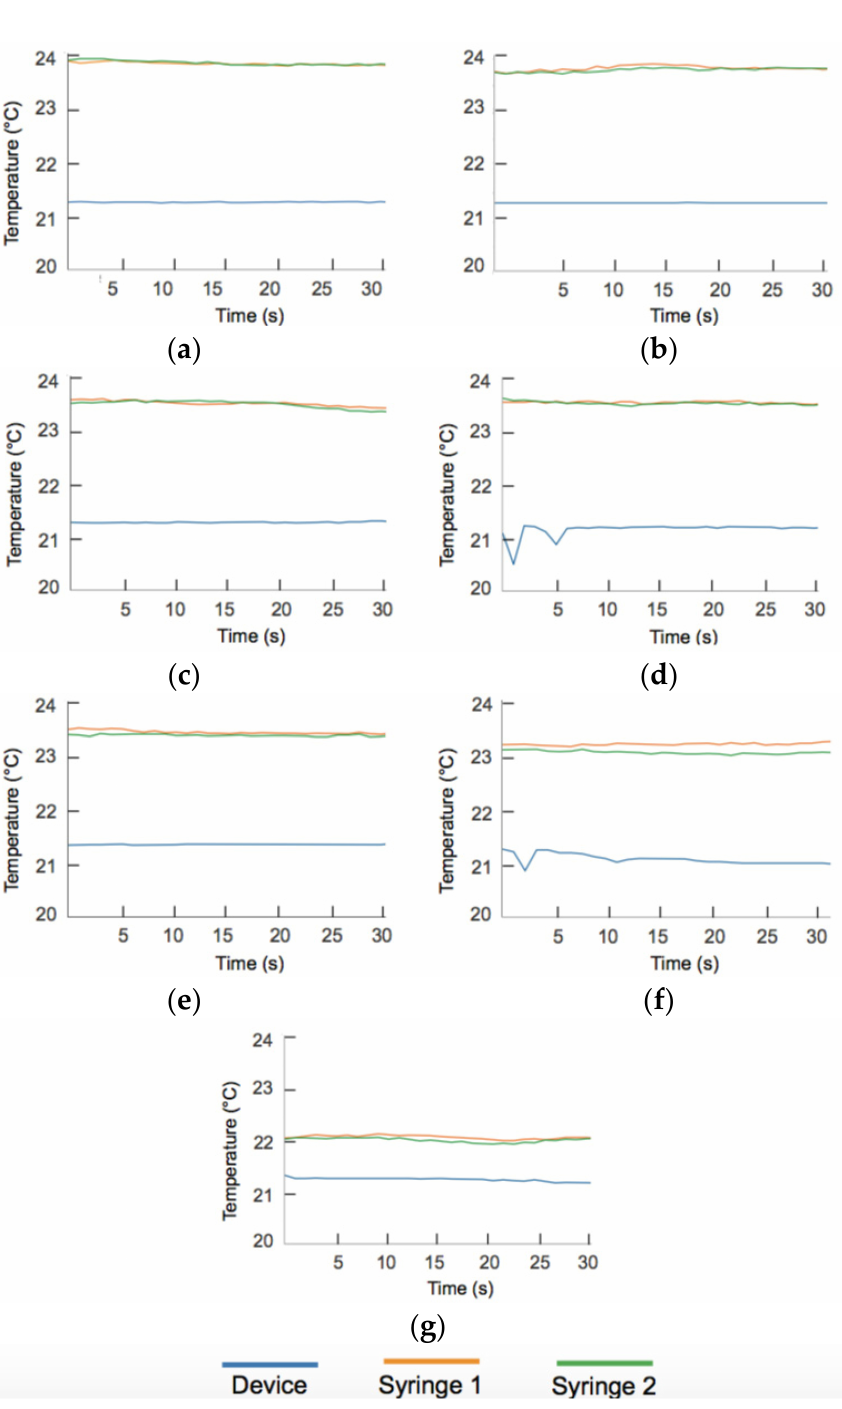
Figure A3. Temperature recordings over the steady state measurement period in the continuous flow titration experiment described in Results and Discussion. The equivalence point in the titration occurs in the condition Q A “ Q B . This is seen when the difference between the average syringe temperature and the device temperature is minimal across a range of volumetric mixing ratios, reflecting maximal device heating. See Section 4 for a detailed description of experimental protocol. ( a ) Q A = 0 mL/h, Q B = 5 mL/h; ( b ) Q A = 5 mL/h, Q B = 0 mL/h; ( c ) Q A = 1 mL/h, Q B = 4 mL/h; ( d ) Q A = 4 mL/h, Q B = 1 mL/h; ( e ) Q A = 2 mL/h, Q B = 3 mL/h;( f ) Q A = 3 mL/h, Q B = 2 mL/h; ( g ) Q A = 2.5 mL/h, Q B = 2.5